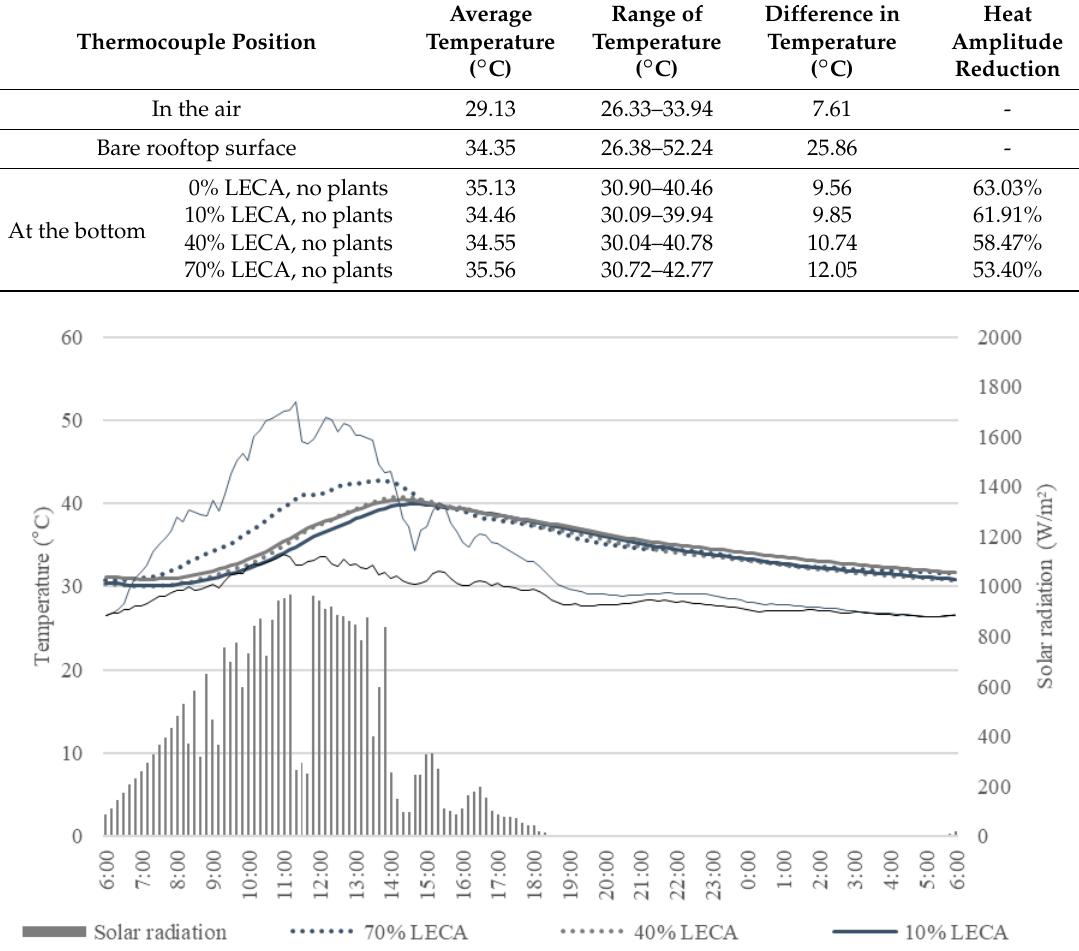
Table 7. Reductions in heat amplitude in the cases of the roofs with 0%, 10%, 40%, and 70% LECA laid at the bottom without plants (25 July 2017 06:00:09 to 26 July 2017 05:50:09).